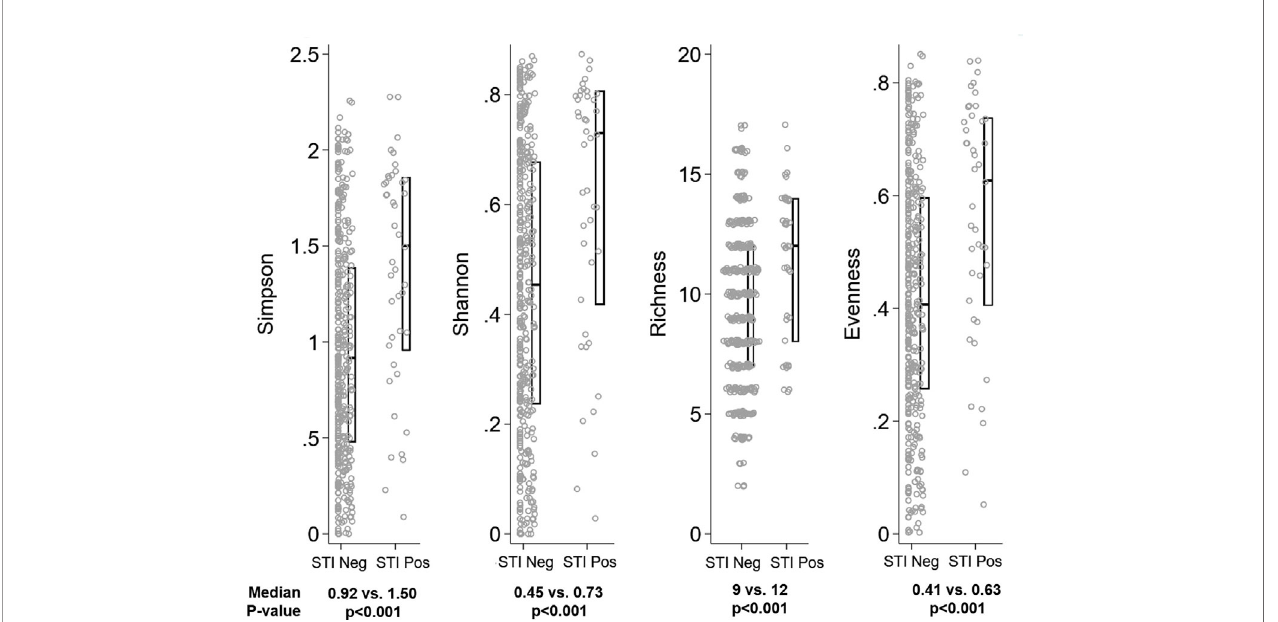
FIGURE 5 | Distribution of alpha diversity metrics by Sexually Transmitted Infection (STI) status. Legend: The distribution of alpha diversity metrics (Simpson, Shannon, Richness, and Evenness) are shown on the y-axis, separately for girls testing negative for all three STIs ( “ STI Neg ” , N=43) and testing positive for any STI ( “ STI Pos ” , N=388) on the x-axis. Within panels, each grey dot represents a single observation. Box plots indicate the median (horizontal bar) and interquartile range (lower 25 th percentile and upper 75 th percentile). Below each graph, the median value for each alpha diversity metric is reported for “ STI Neg ” and “ STI Pos ” observations, with Wilcoxon rank sum p-value of the comparison reported beneath the medians.